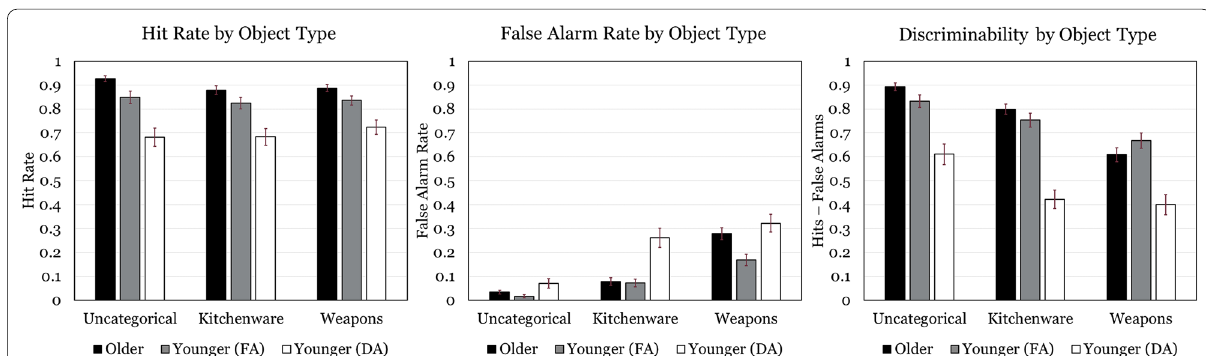
Fig. 4 Hit rate, false alarm rate, and average discriminability for each object type and age/attention group. FA Attention